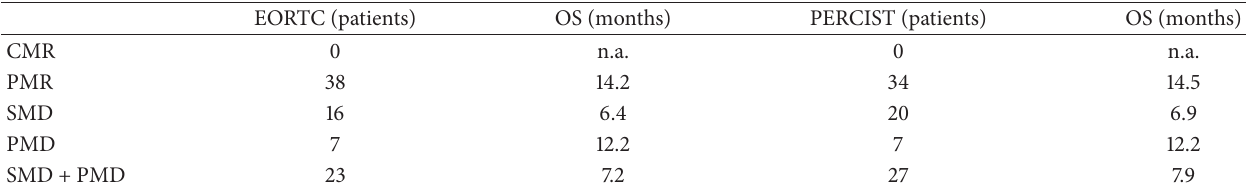
Table 2: Comparison of the two methods to assess the response and overall survival